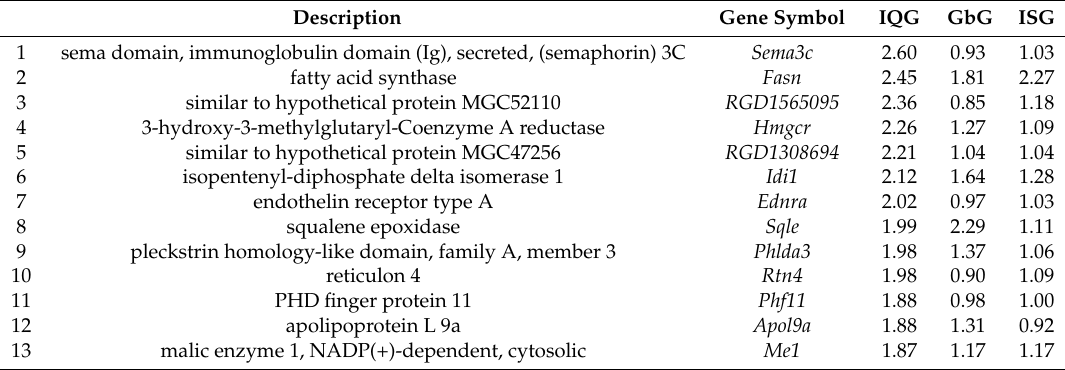
Table 5. Up-regulated genes differentially expressed in the liver tissue of high fat diet rats treated with insect glycosaminoglycan over a one month period. Description Gene Symbol GbG ISG sema domain, immunoglobulin domain (Ig), secreted, (semaphorin)